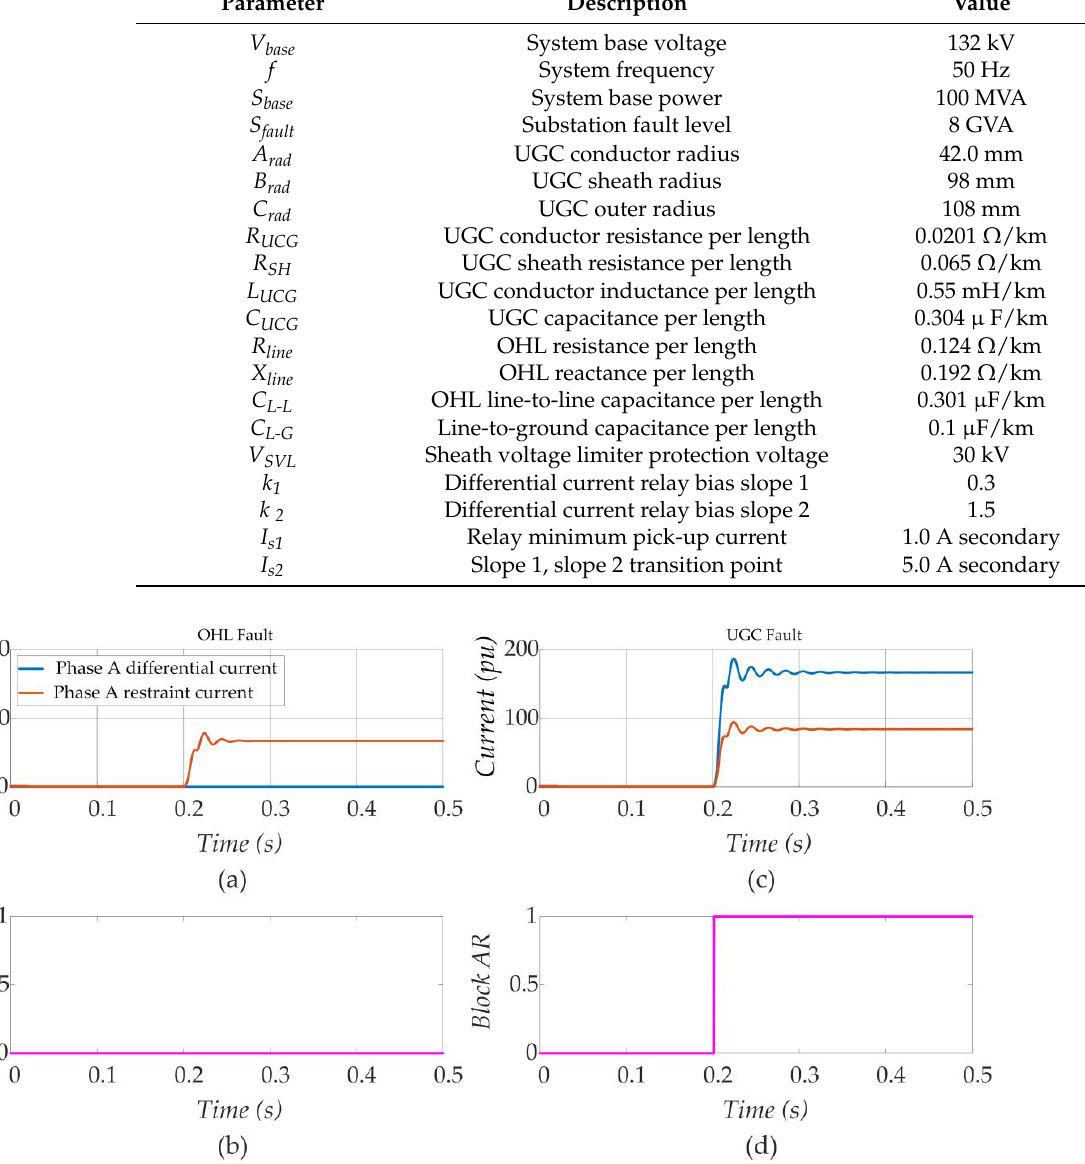
Figure 3. Performance of the multi-zone differential scheme; ( a ) OHL fault; ( b ) AR not blocked for OHL fault; ( c ) UGC fault; ( d ) AR blocked for UGC